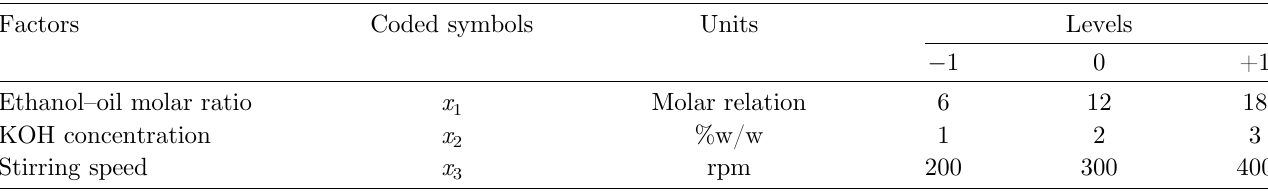
Table 1. Independent factor level settings for a biodiesel production process.